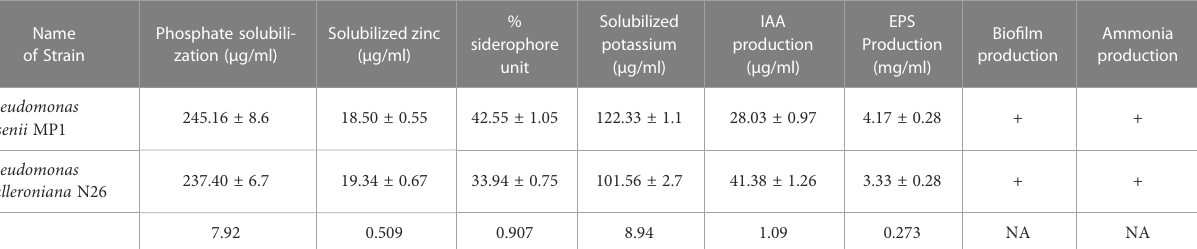
TABLE 1 Plant probiotic traits of P. jesenii MP1 and P. palleroniana N26.